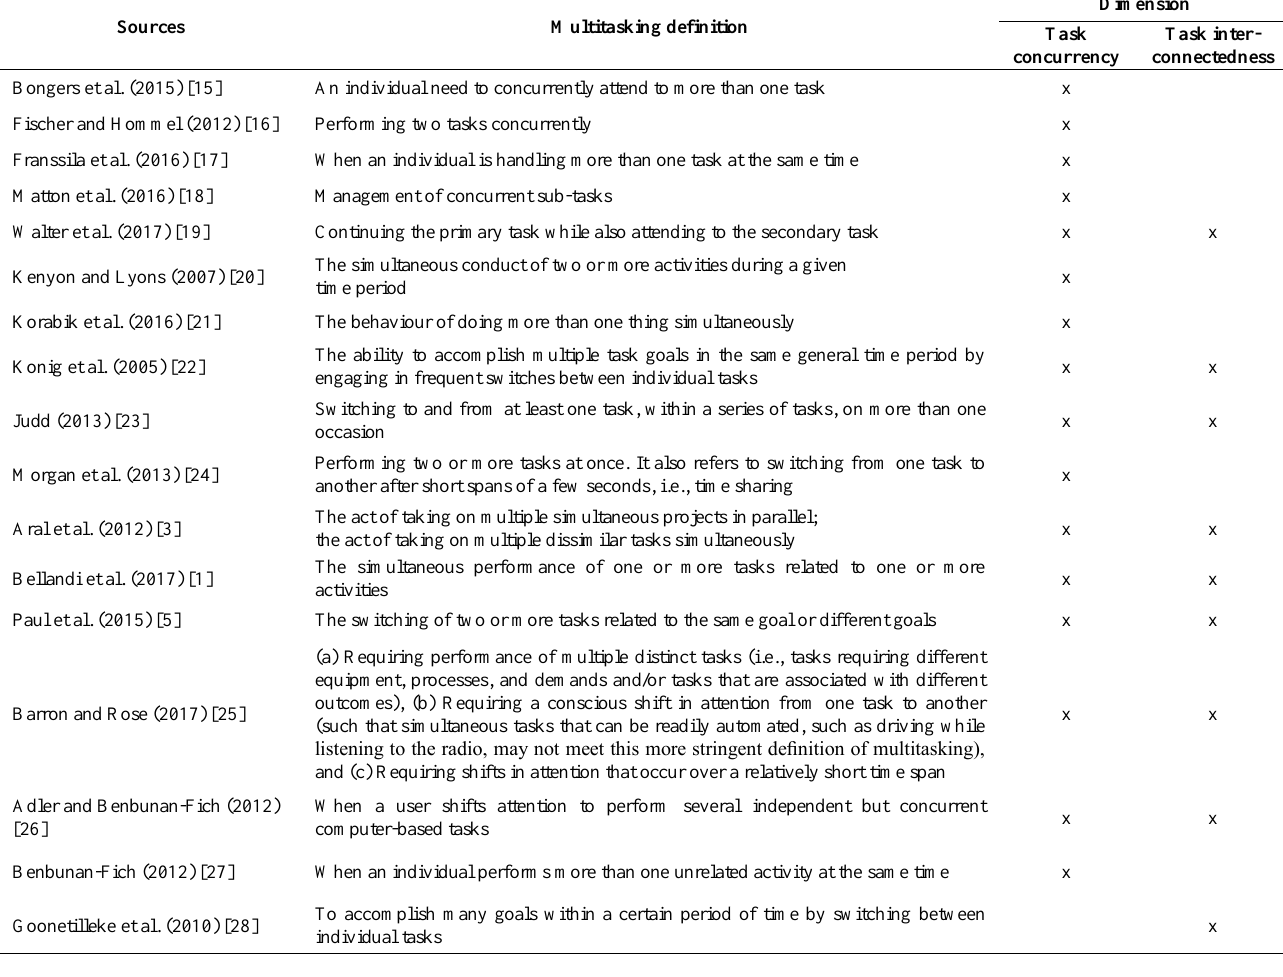
Table 1. Definitions of the term “multitasking” based on literature